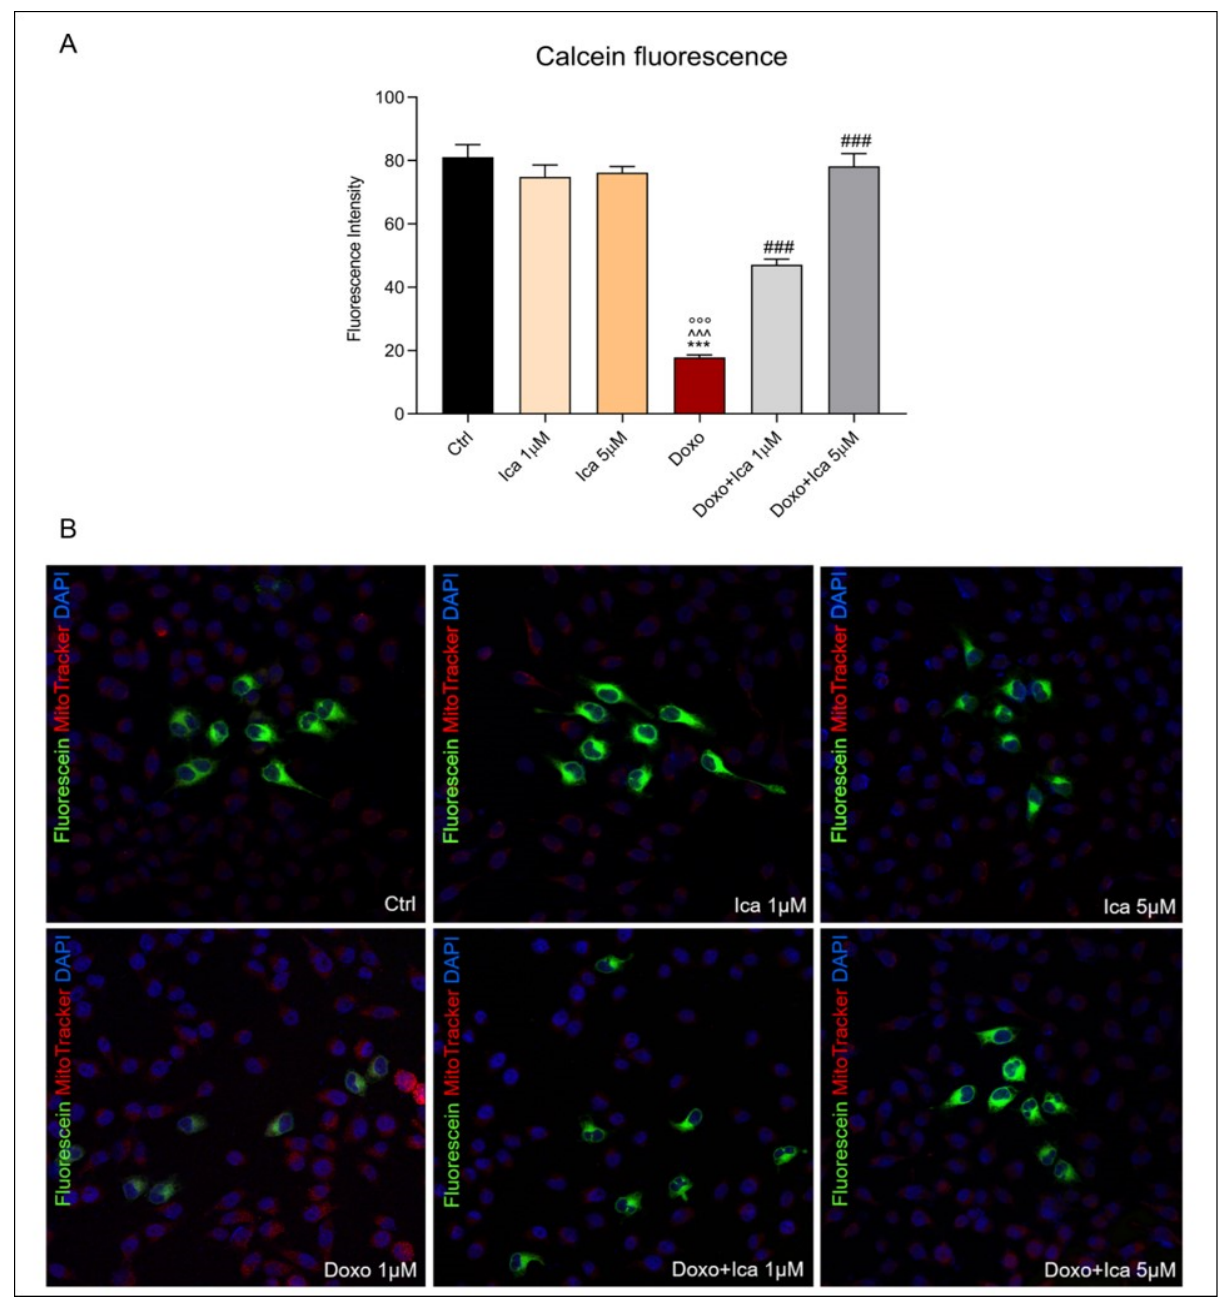
Figure 5. The effect of Ica on mitochondrial permeability transition pore opening in Doxo-treated H9c2 cells. ( A ). Mitochondrial permeability transition pore (mPTP) opening was determined by immunofluorescence assay. Fluorescence was quantified using ImageJ ® software by converting the intensity to a greyscale value based on the RGB color model. For each treatment, 30–40 cells were processed. Significant differences in mean fluorescence were found between all treated cells. ( B ). Confocal representative images of H9c2 cells treated as described above. Green staining showed calcein, blue staining showed Hoechst 33342 used for nucleic acid staining, red staining showed MitoTracker Red CMXRos used for mitochondria staining. Cell images were collected using a 40× confocal microscope objective. Data are expressed as mean ± SEM, *** p < 0.001 vs. Ctrl; °°° p < 0.001 vs. Ica 1 μ M ^^^ p < 0.001 vs. Ica 5 μ M; ### p < 0.001 vs. Doxo; Kruskal-Wallis test and Dunn’s multiple comparisons test ( n = 3). Data is from three independent experiments.